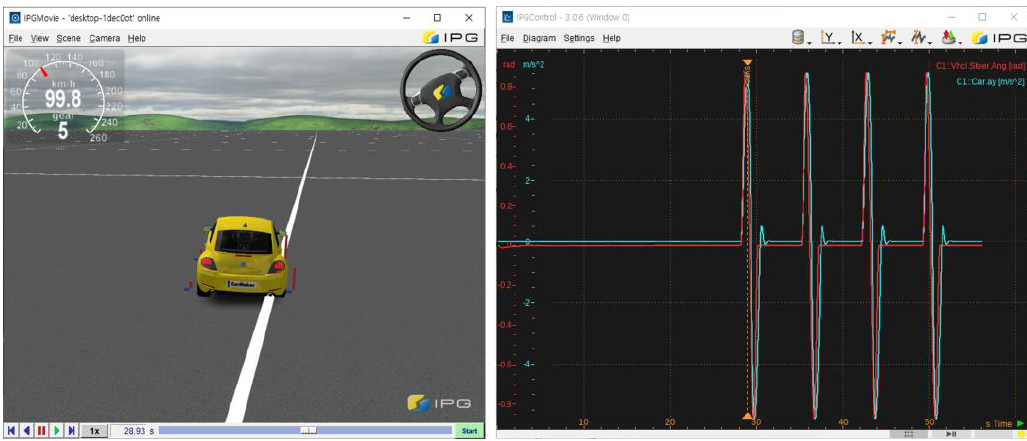
Figure 6. IPG CarMaker Software Simulation.